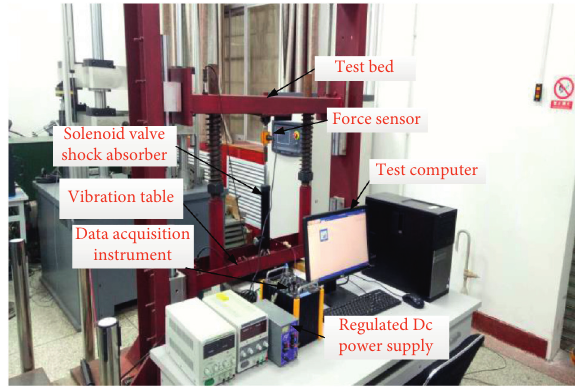
Figure 5: Velocity characteristic test of the solenoid valve shock absorber.